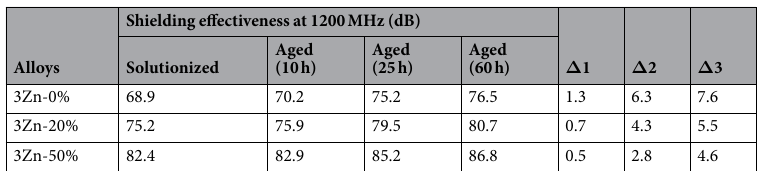
Shielding effectiveness at 1200 MHz (dB) Alloys